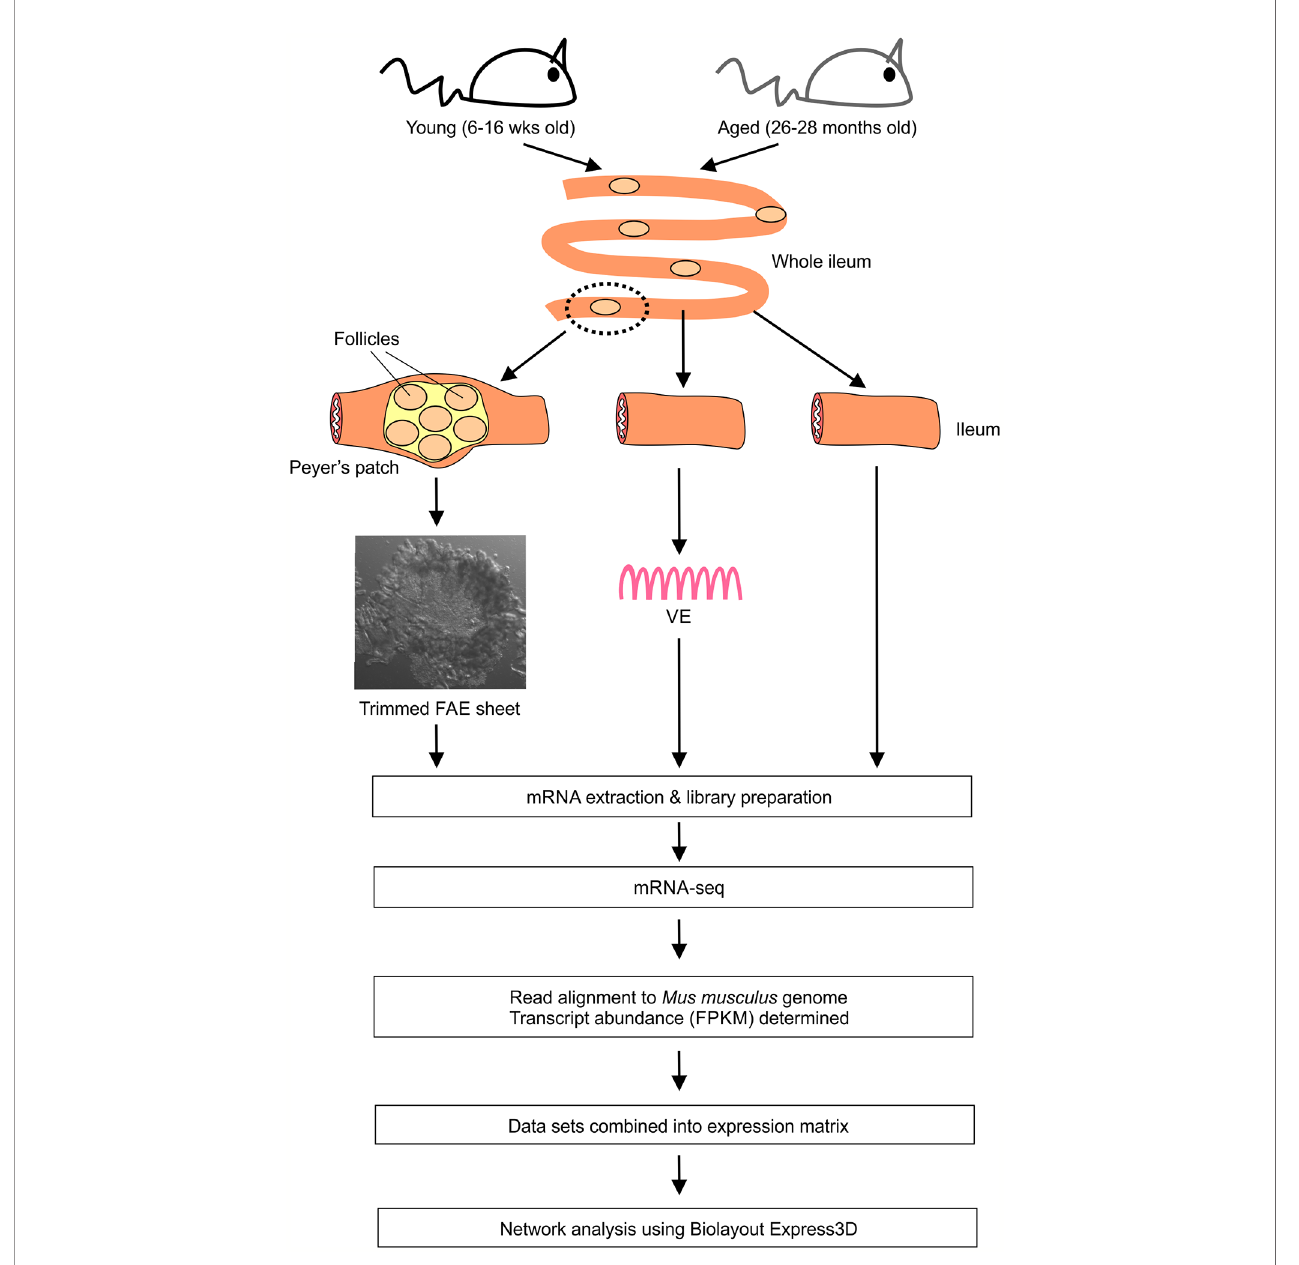
FIGURE 1 | Study design and work- fl